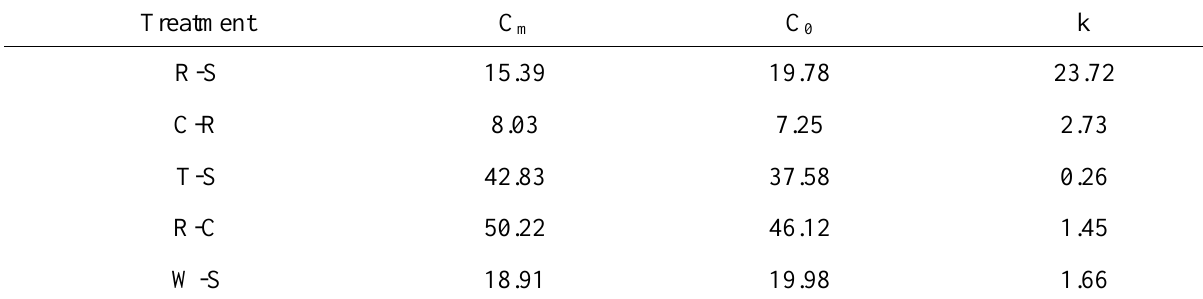
Table 3. Parameters of the first-order kinetic model [C m =C 0 (1-e -kt )] used to describe C-mineralisation of the organic materials. C m = mineralised-C (% of TOC added), C 0 = potentially mineralisable-C (% of TOC added), k = rate constant (day -1 ). Treatment: R-S = Reed sweet-grass digestate, C-R = Common reed digestate,